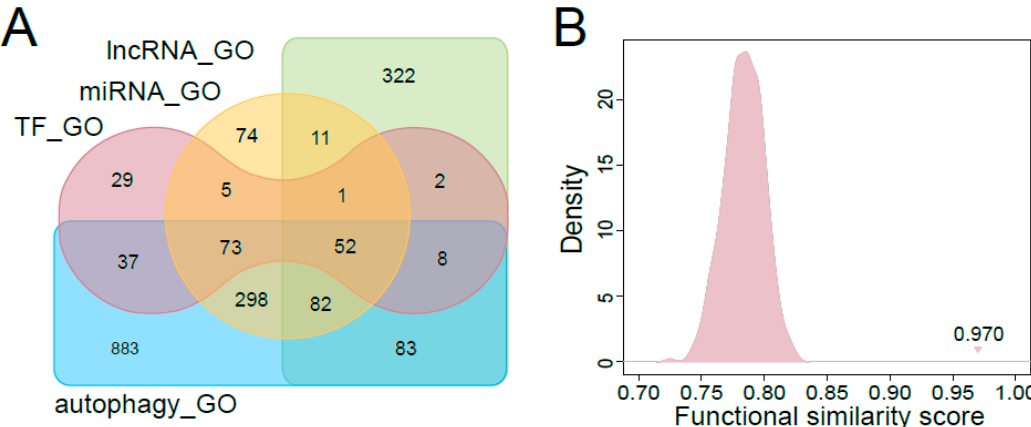
Figure 4. Evaluation of the top ranked regulators associated with autophagy. ( A ) Venn plot for the GO functional annotation comparison among the top ranked TFs, miRNAs, lncRNAs and the known autophagy-associated factors. ( B ) Distribution of random functional similarity scores for the top ranked TFs and the autophagy-associated factors. The triangle indicates the true functional similarity score for top ranked TFs and the known autophagy-associated factors.